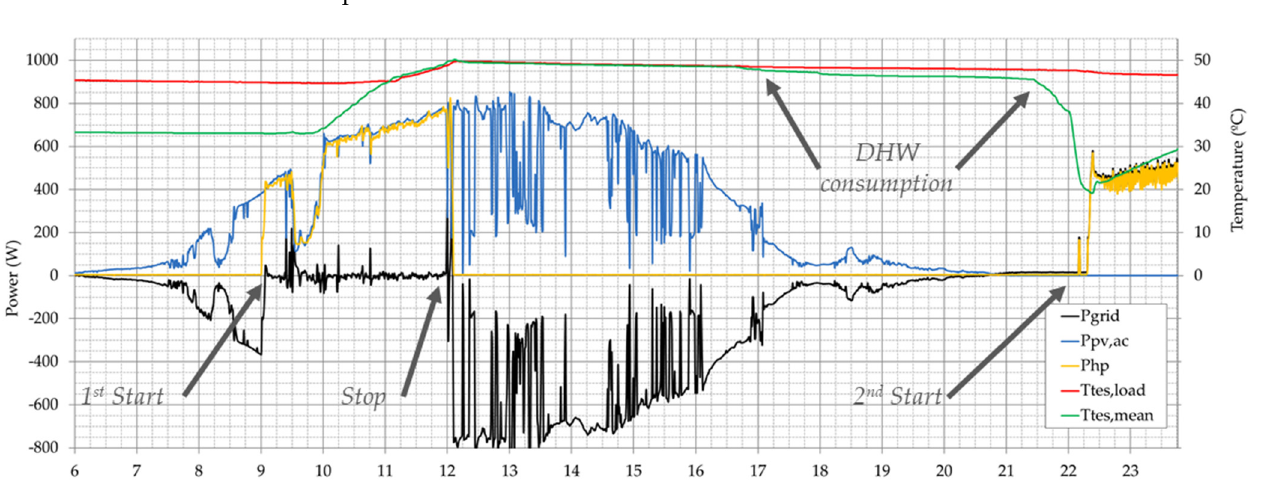
Figure 7. Main system electric power and TES state of charge profiles for the 15 July.